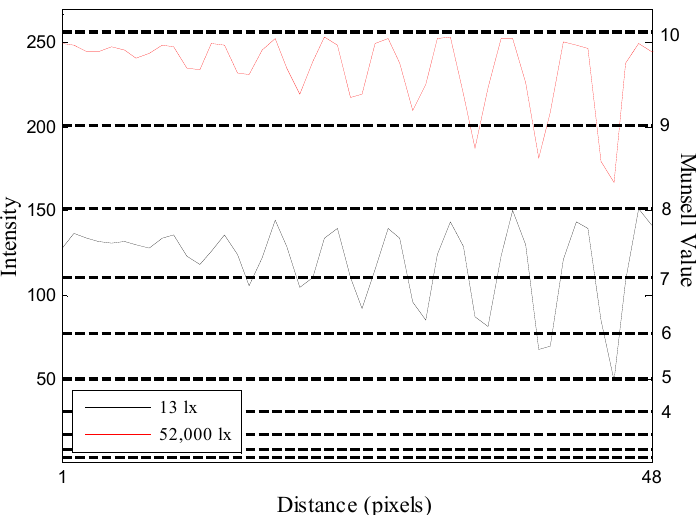
Figure 20. Intensity profile and Munsell value of crack images acquired at the image acquisition distance of 100 m.